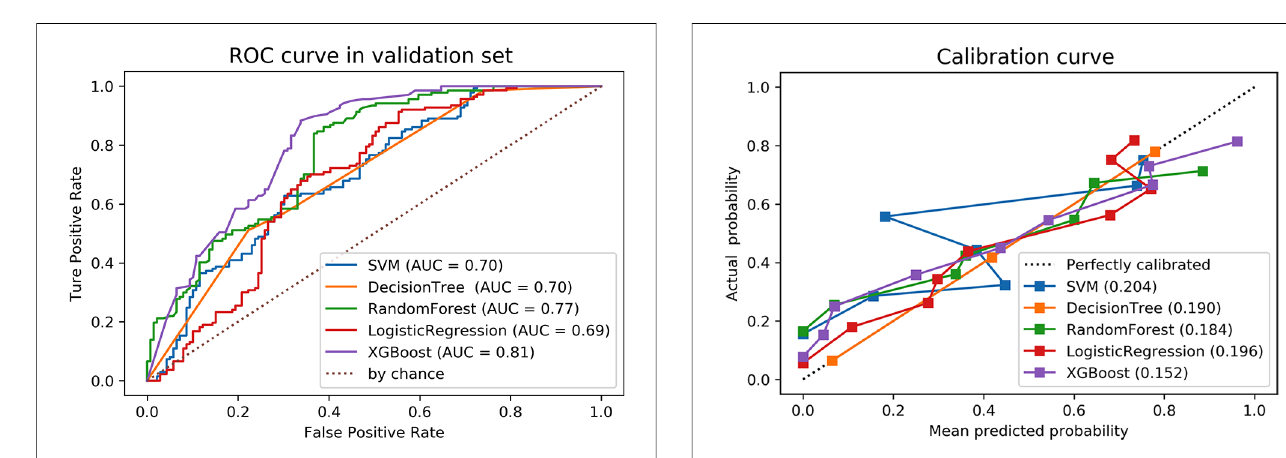
FIGURE 2 Evaluation of the fi ve machine learning models based on the AUC of the ROC curve in validation set. AUC, area under the curve; ROC, receiver operating characteristic.